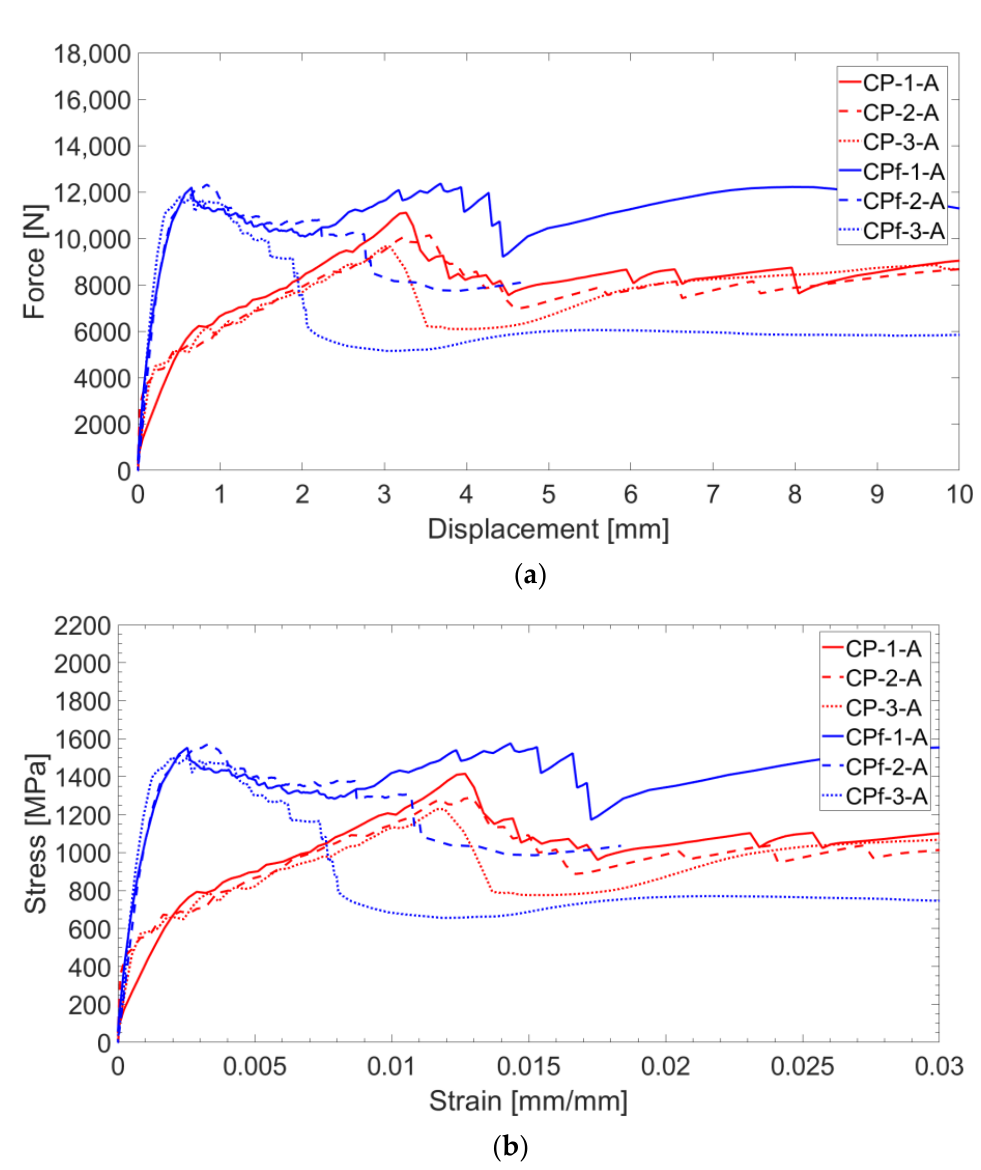
Figure 10. Force – displacement ( a ) and stress – strain ( b ) curves of C-TRC (in red) and C-F/TRC Figure 10. Force–displacement ( a ) and stress–strain ( b ) curves of C-TRC (in red) and C-F/TRC specimens (in blue). specimens (in